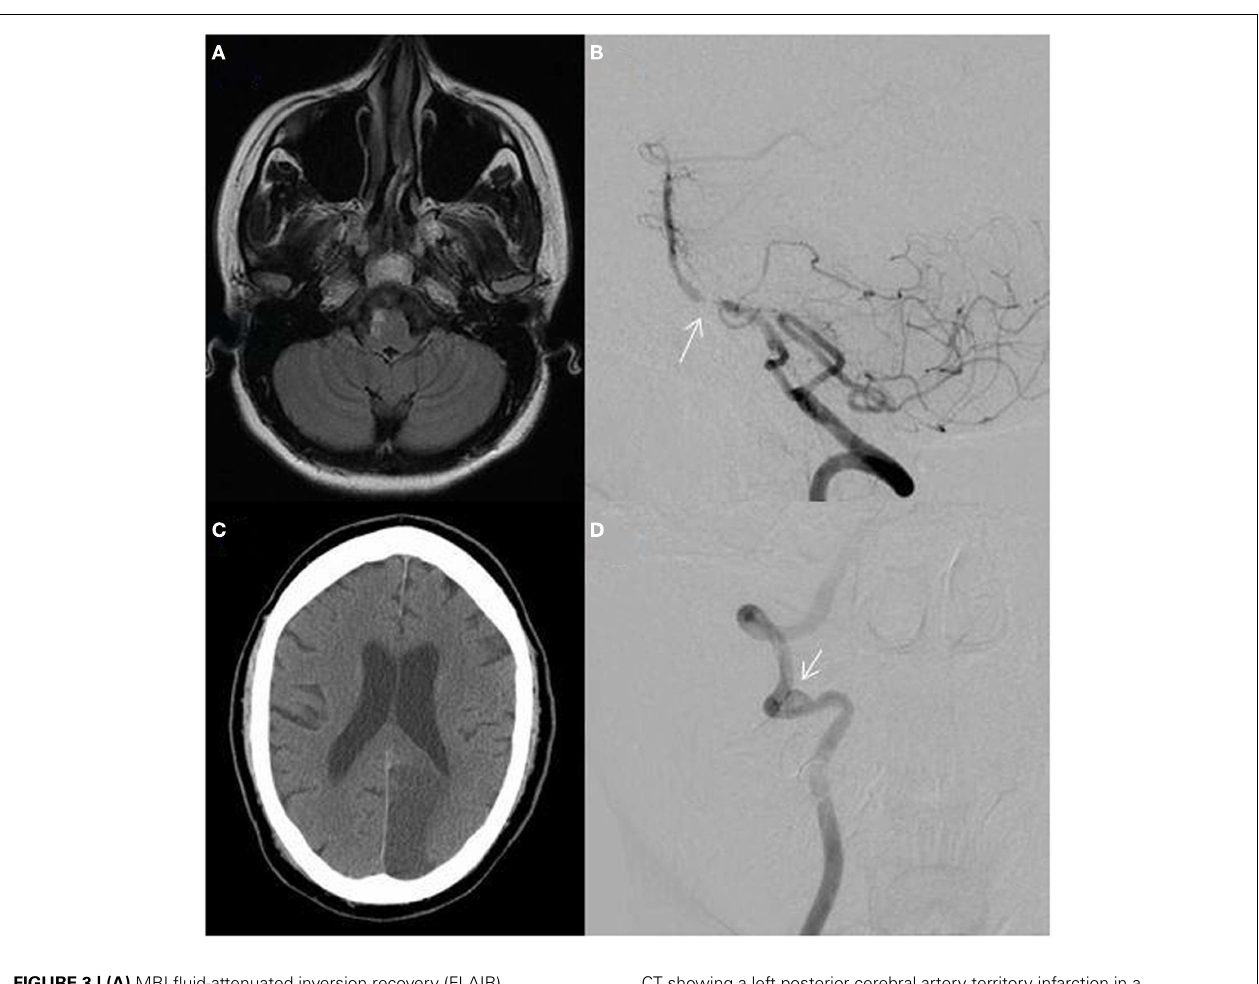
FIGURE 3 | (A) MRI fluid-attenuated inversion recovery (FLAIR) sequence showing a right lateral medullary infarction in a 32-year-old woman with a hypoplastic right vertebral artery shown in Figure 2A ; (B) catheter angiogram of a 55-year-old African-American man showing atherostenosis at the vertebrobasilar junction (arrow); (C) non-contrast